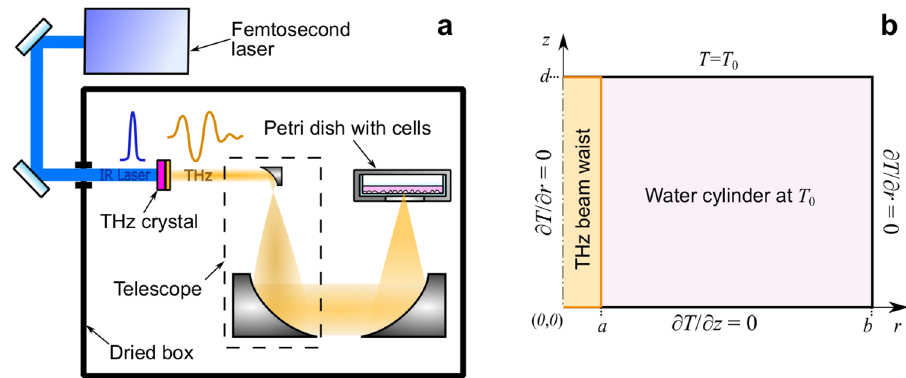
Figure 1. Experimental setup for cell irradiation. ( a ) Schematic diagram. ( b ) Cross-section of the water cylinder used in numerical modelling of heat transfer caused by exposure to THz radiation: b and d are the radius and the thickness of the cylinder, respectively, a is the radius of the THz